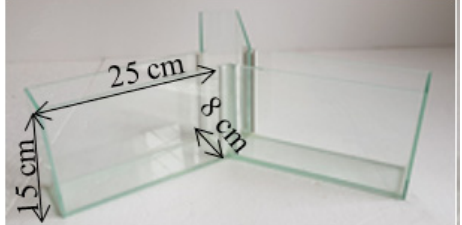
Figure 5. Y-maze glass tank.